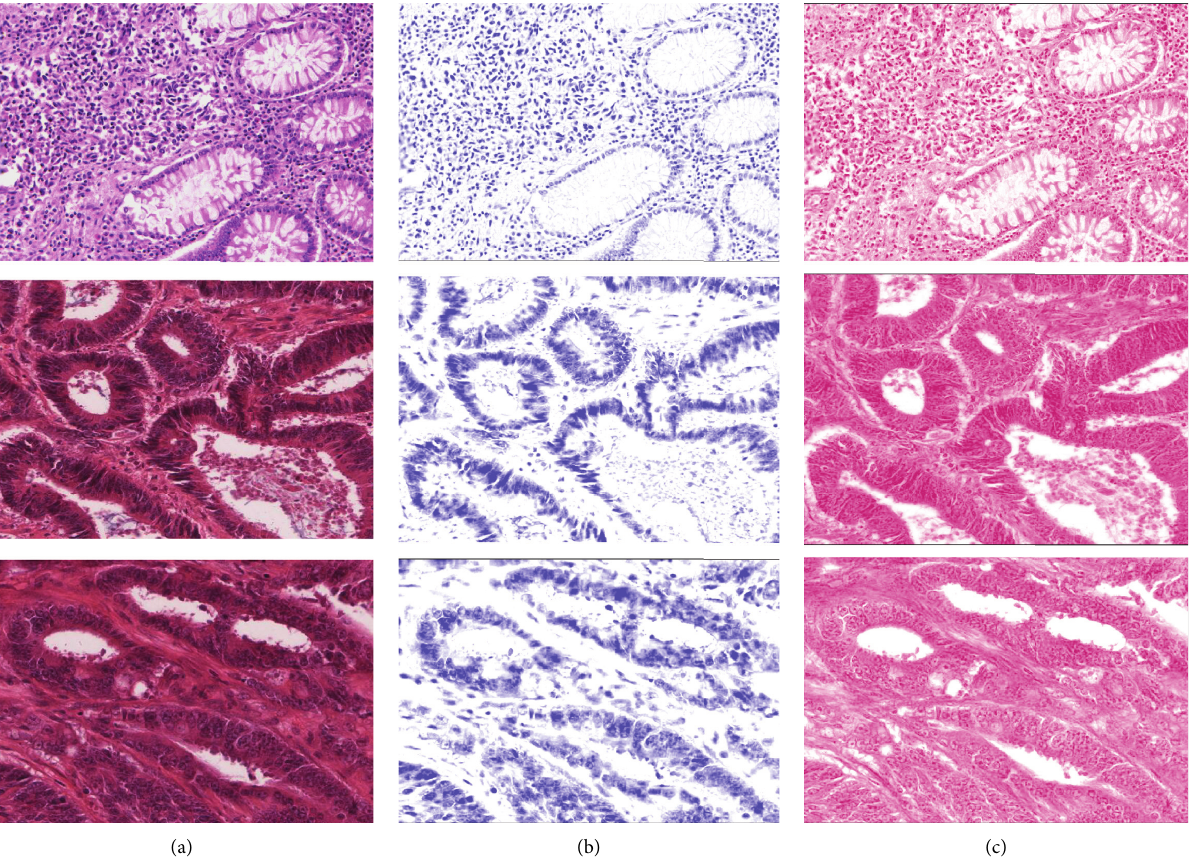
Figure 8: H&E-staining and separation results of different datasets: (a) original pathological image, (b) H-staining image, and (c) E-staining